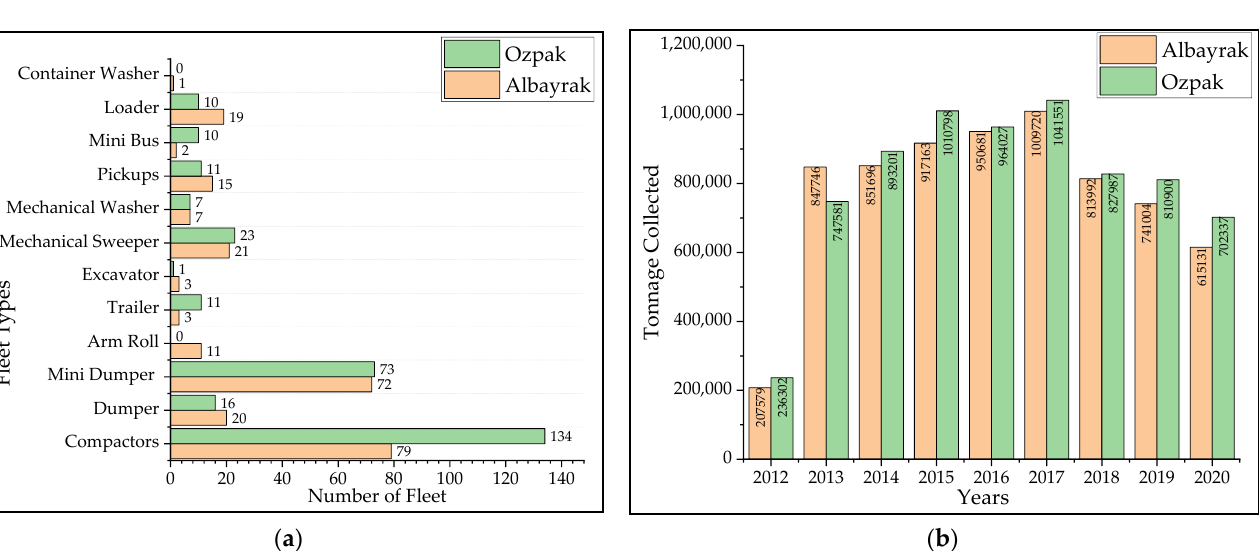
Table 2. Lesson learned from previous SWM outsourcing contracts .